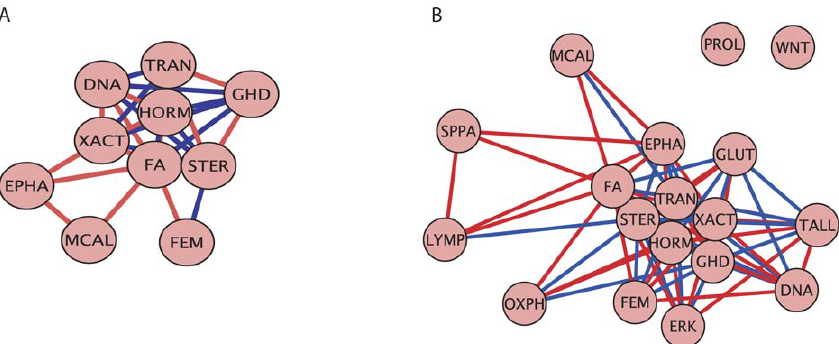
Figure 2. Pathway Association Graphs An association graph of (A) the top 10 gene sets in the f b a p g transition and (B) the gene sets with p , 0.05 for the f b a p g transition. The red lines indicate a positive dependence while the blue lines indicate a negative dependence. Distances between gene sets reflect the strength of dependencies. See Table S2 for full pathway names.